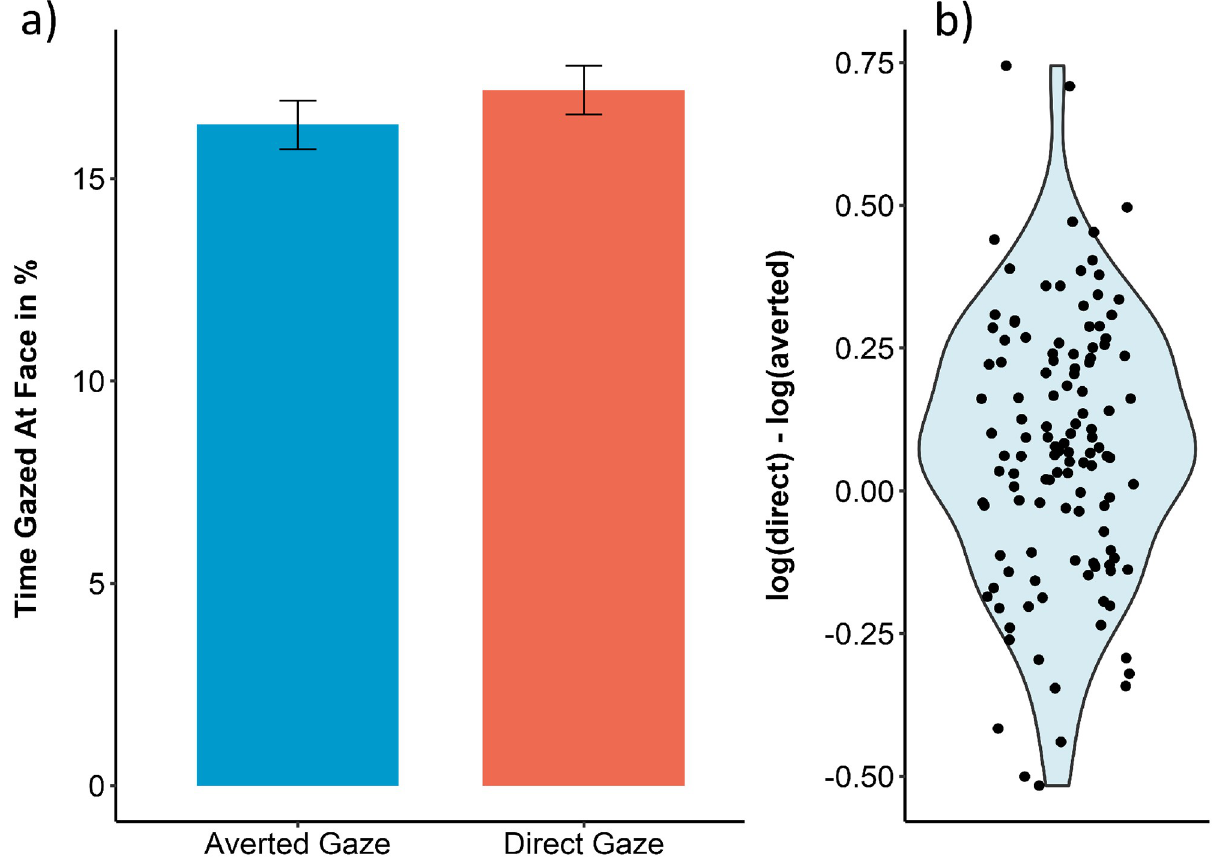
Fig 1. (a) Time spent looking at faces when they looked away from the camera (averted gaze) compared to when they looked into the camera (direct gaze). Error bars represent SEM. (b) Violin plot showing the differences between attention towards faces when depiciting direct compared to averted gaze for all 120 participants. Positions on the x-axis are randomized for better visibility. This graph shows log-transformed data, directly corresponding to the statistical analysis described in the text.